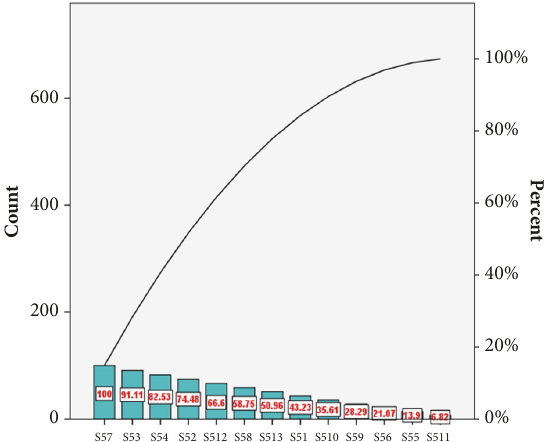
Figure 12: Pareto chart for project executing and monitoring management process group.